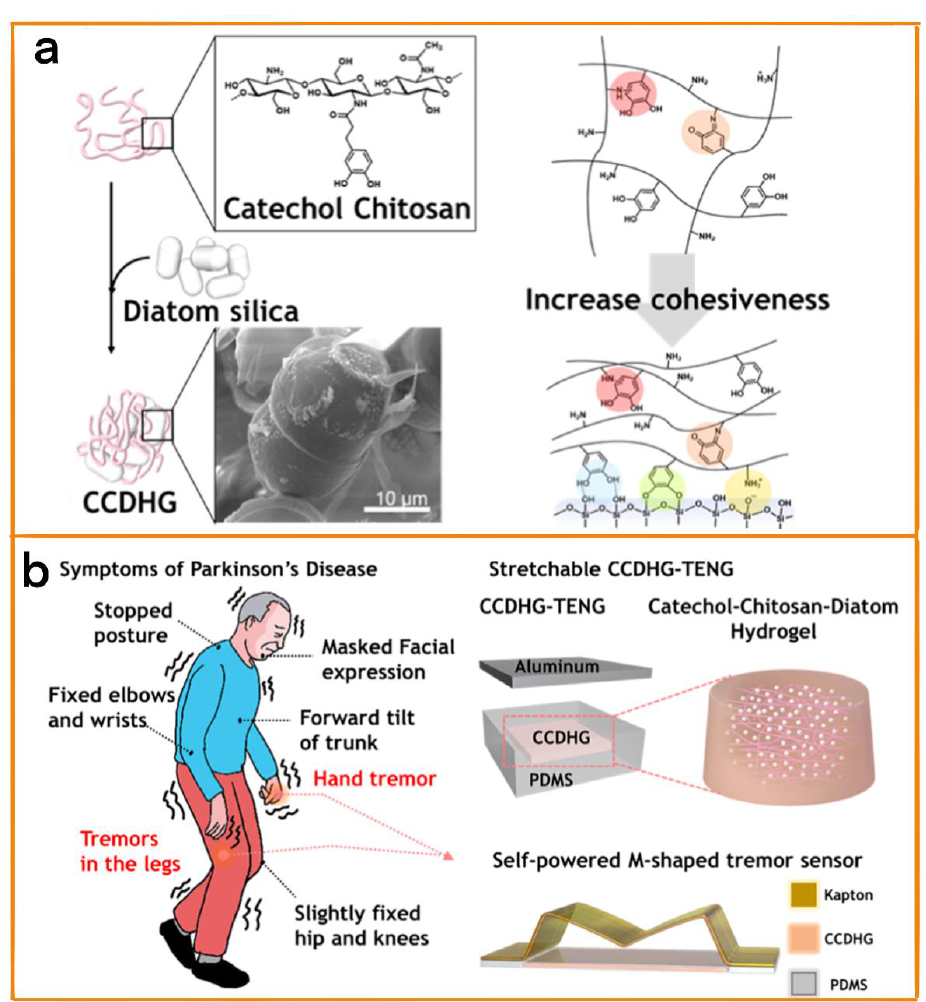
Figure 7. ( a ) Preparation method of catechol chitosan diatom hydrogel, and the mechanism of enhancing the cohesion of catechol chitosan diatom hydrogel. Optical image. ( b ) Typical symptoms of Parkinson’s disease. Schematic diagram of catechol chitosan diatom hydrogel triboelectric nanogenerator and vibration sensor. Reprinted with permission from [64] 2021, Elsevier.